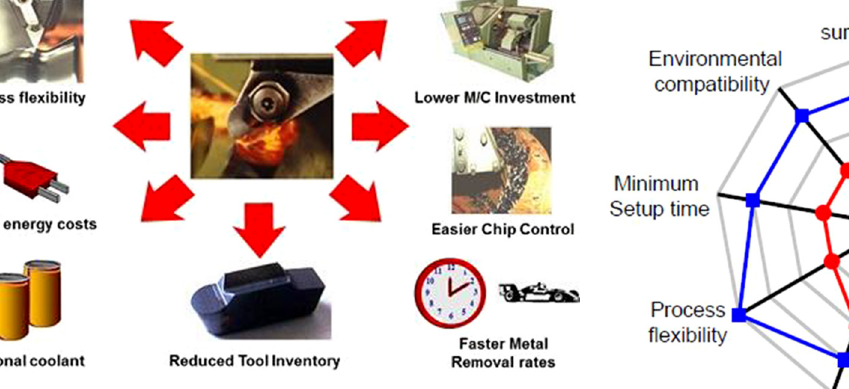
Fig. 1. Economic bene fi ts of hard turning [4].